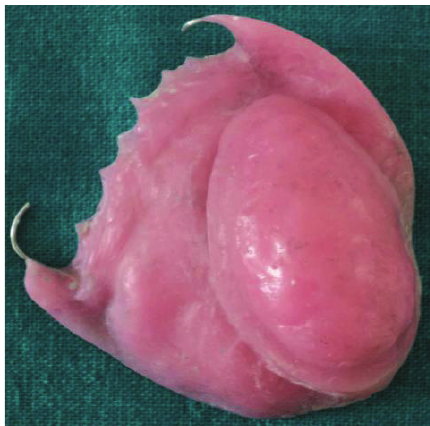
Figure 14: Bulb with prosthesis.